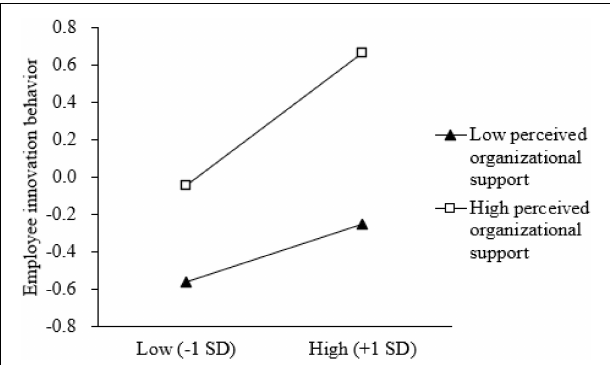
FIGURE 2 | Moderating diagram of organizational support on mediating